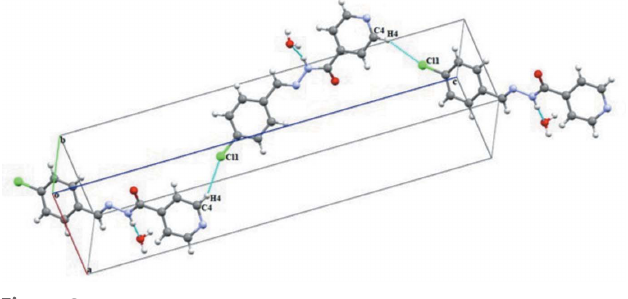
Figure 3 Part of the crystal structure showing weak C—H (cid:2)(cid:2)(cid:2) Cl hydrogen bonds as dashed lines.